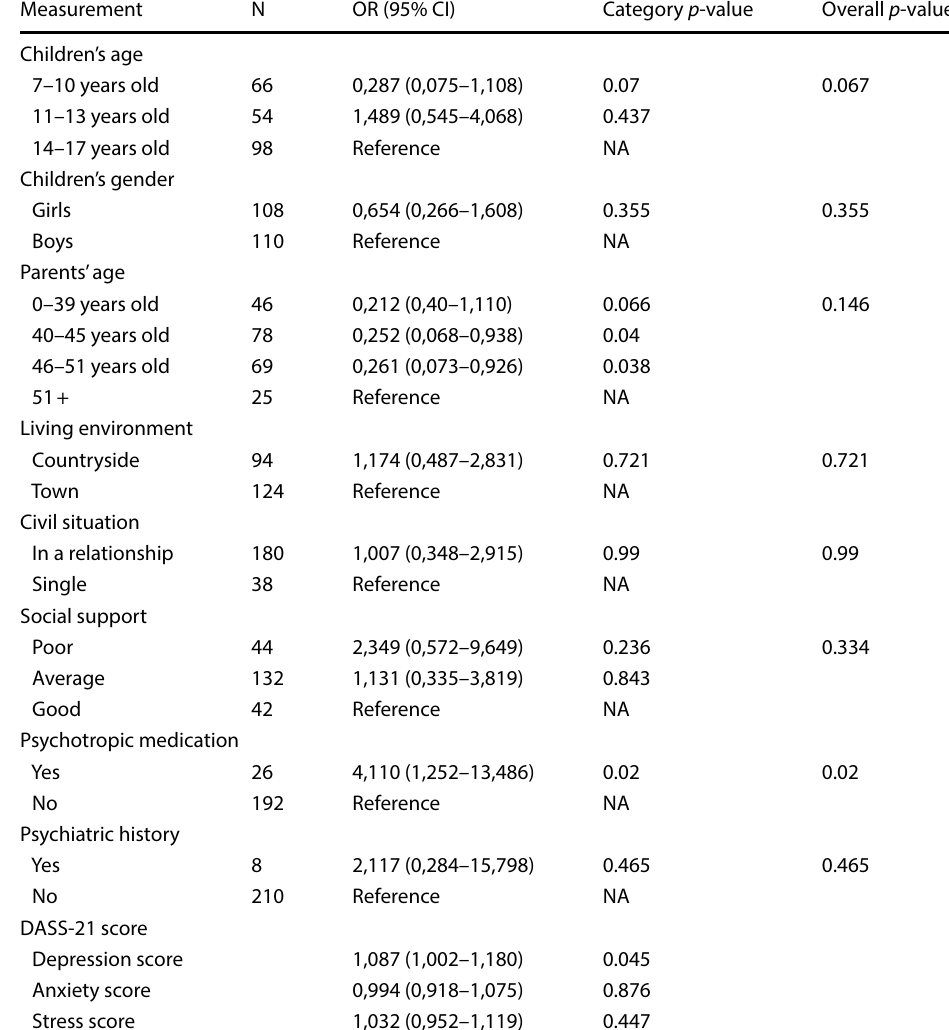
Table 5 Adjusted Risk Factor for Child